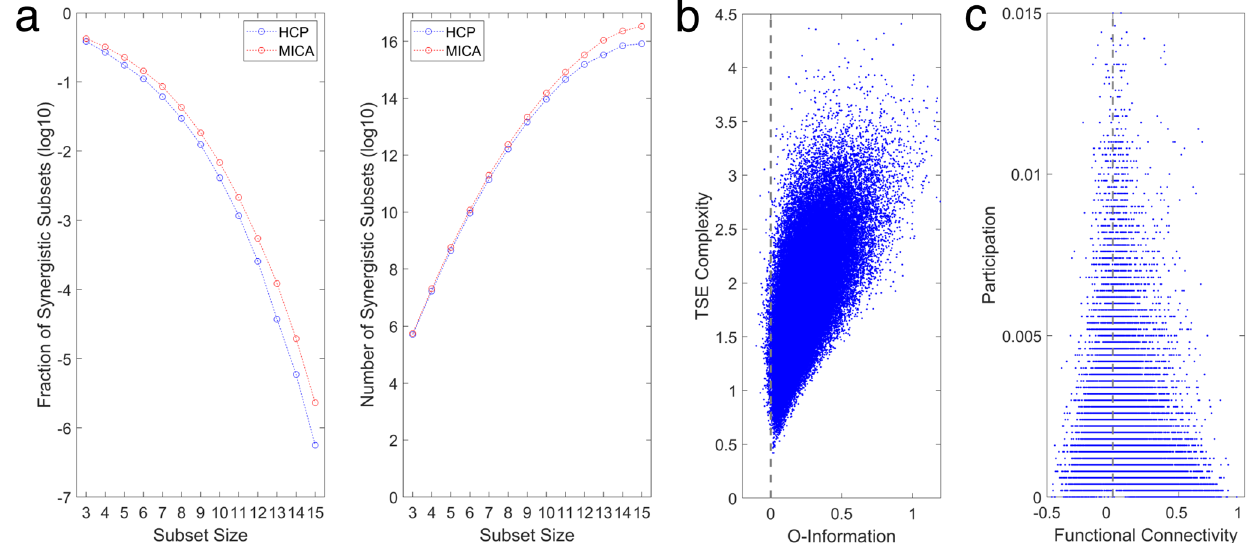
Fig. 3 Information measures computed from randomly sampled 10-node subsets. a Fraction (left) and number (right) of subsets with negative O- information, obtained by randomly sampling subsets from the HCP (blue) and MICA (red) FC matrix. Fraction and number estimated from samples of 5000 (3 – 12 nodes) or 200 (13 – 15 nodes) subsets with negative O-information. As the size of the subset grows, the fraction expressing an overall synergy- dominated structure (negative O-information) drops precipitously, while their absolute number continues to climb due to combinatorics. b The relation between O-information and TSE complexity in 100,000 randomly sampled 10-node subsystems (HCP data). While very few randomly sampled sets have negative O-information (see panel a ), TSE complexity generally increases with the strength of the dependencies visible to the O-information ( R = 0.642, p = 0). c The participation quanti fi es, for each node pair, how often they are encountered as part of a subset with negative o-information (10 nodes, 5000 random samples, HCP data), The plot shows the relation of the participation against the FC, with each data point representing one of the 19,900 unique node pairs. Node pairs with strong mutual FC (positive or negative) are rarely encountered as part of the same synergistic subset, while node pairs that are more frequently encountered tend to show weak FC. Spearman ’ s rho between absolute FC and participation: ρ = − 0.504, p = 0.